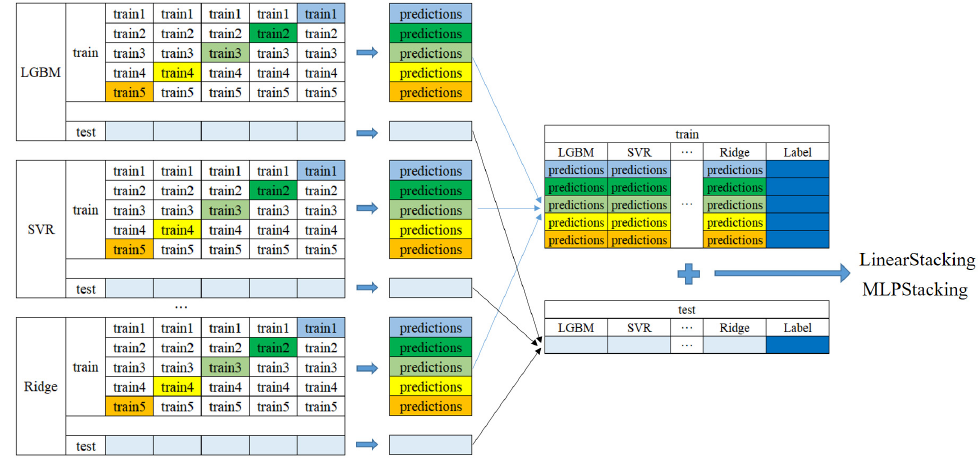
Figure 4. Flow chart of feed intake rate prediction by model stacking.